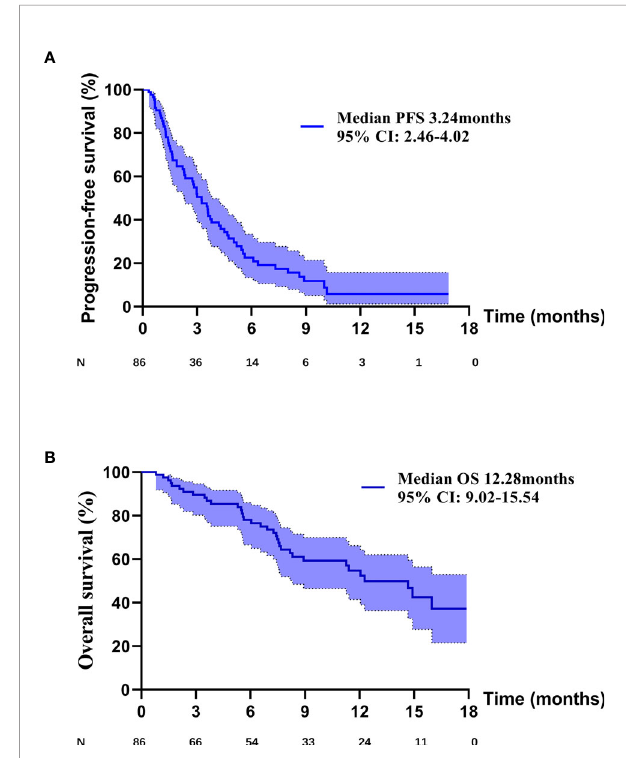
FIGURE 1 | (A) The PFS curve of overall patients. (B) The OS curve of overall